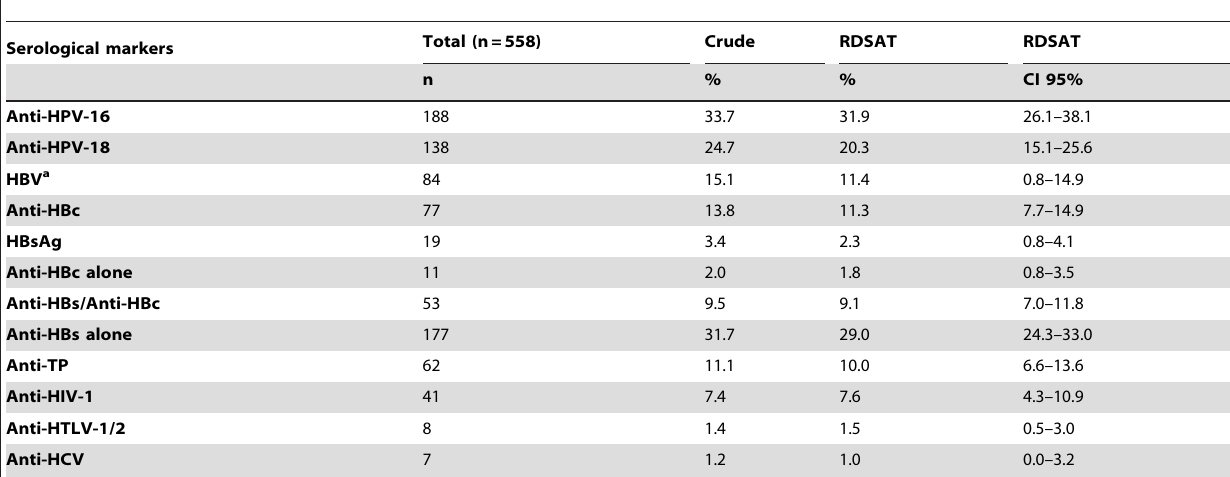
Table 2. Prevalence of serological markers of infections not adjusted and adjusted by